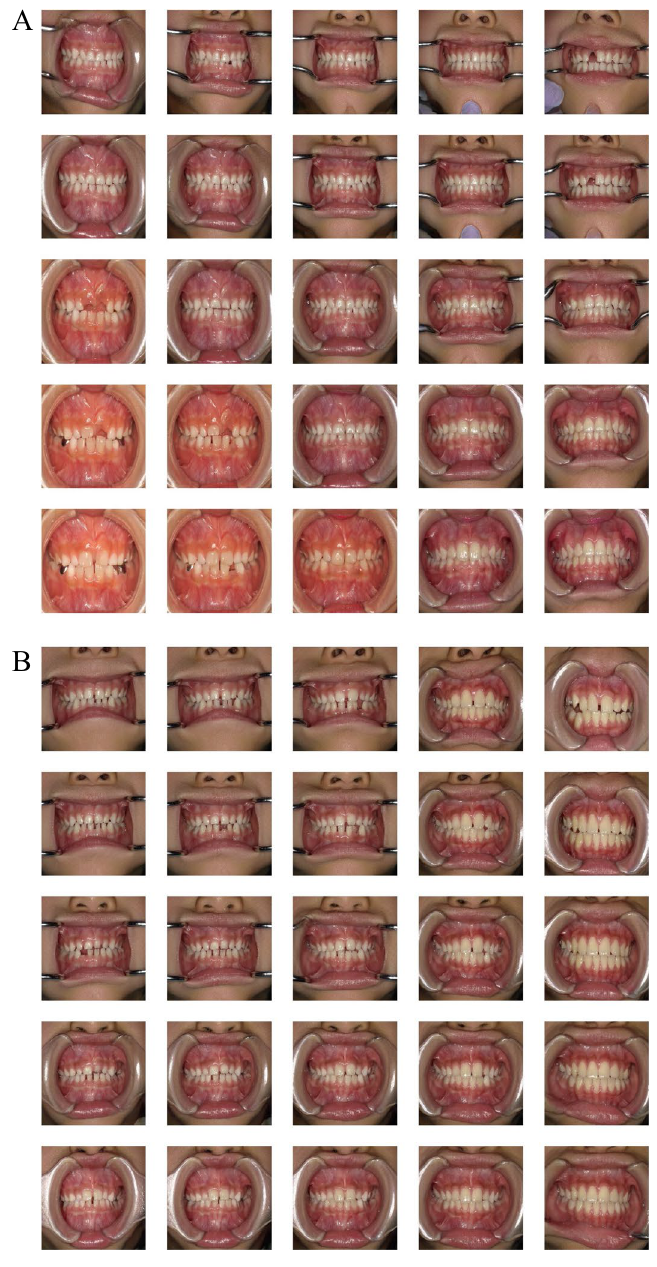
Figure 6. An example of exploring latent space. The images generated by PGGAN are gradually changing between one end and the other, from primary dentition to permanent dentition. One Supplementary Movie which shows intraoral image generation movie associated with this figure can be found in the online